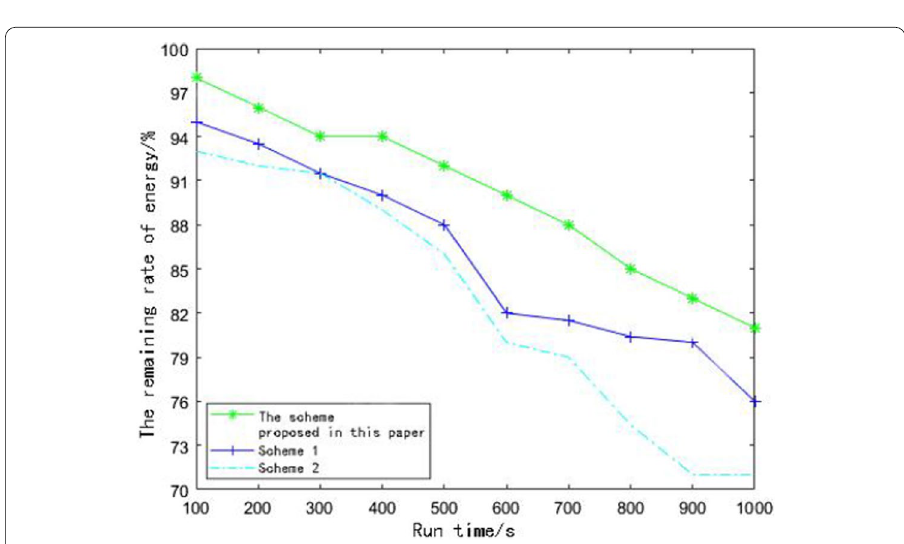
Fig. 5 The remaining rate of